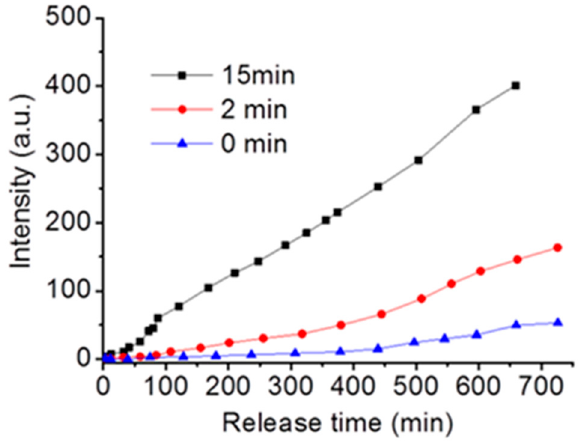
Figure 6. The Polymersomes as carriers for controlled release of hydrophilic drugs, DOX, on exposure to UV light with different times.